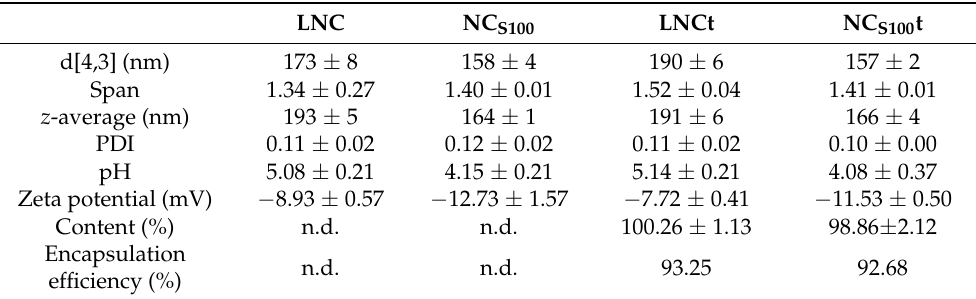
Table 2. Physicochemical characteristics of nanocapsules and lipid core nanocapsules containing toltrazuril or not.